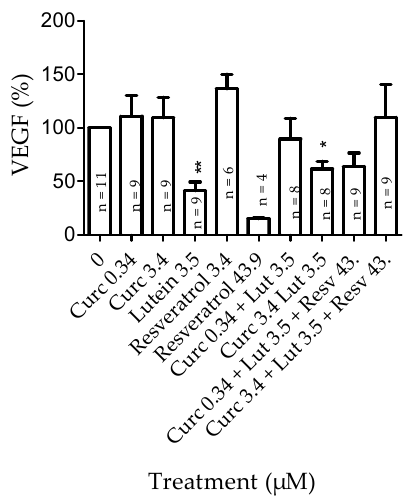
Figure 9. E ff ect of curcumin, lutein, and resveratrol on vascular endothelial growth factor (VEGF) secretion. VEGF amounts were quantified by ELISA in the cell supernatants after a 24 h incubation with natural agents, alone or combined. Results are expressed as mean percentage ± SEM. The number of tests for each condition is indicated in each bar. Each n corresponds to a triplicate. Statistical significance (*) compared to “0”.